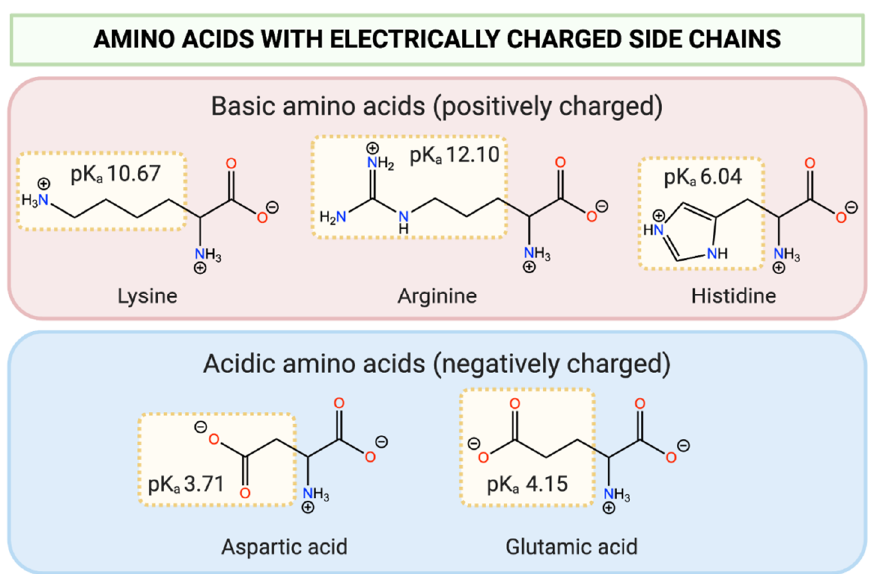
Figure 3. Structure of common basic and acidic amino acids, with the pK a values of side chain functionalities shown (adapted from [52] ).